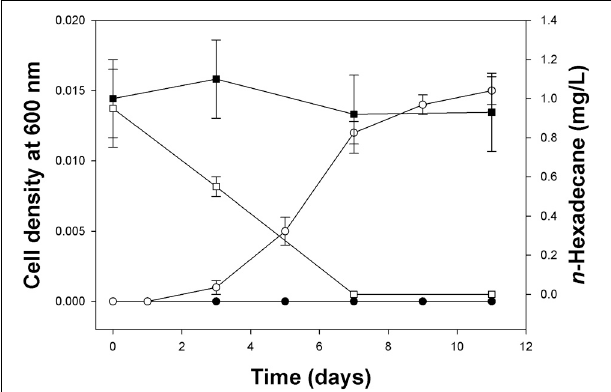
FIGURE 4 | Growth of Methylophaga sp. strain SM14 on n -hexadecane (0.002% v/v) as the sole carbon and energy source and disappearance of the n -hexadecane as measured by GC. Each data point is the mean ± standard deviation from triplicate incubations. Open symbols represent live cultures (non-acid treated); filled symbols represent acid-inhibited controls. Circles and squares are cell density and GC measurements, respectively. Some error bars are smaller than the